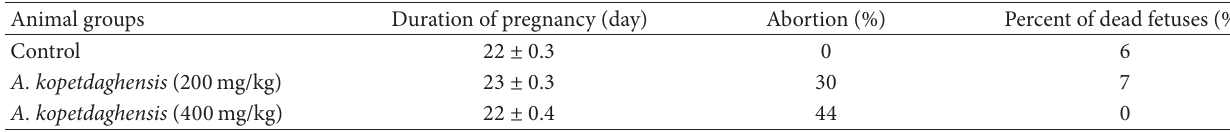
Table 1: Effect of Artemisia kopetdaghensis on reproduction of female rats. The pregnant rats were treated (i.p.) with vehicle or A. kopetdaghensis hydroalcoholic extract from the 2th to 8th day of pregnancy. Values are mean ± SEM ( 𝑛 =